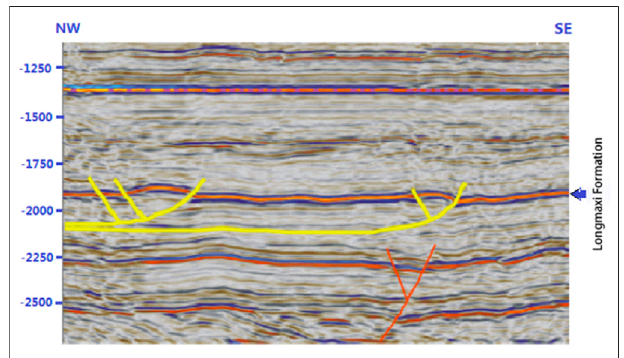
FIGURE 4 | Stratum and style of Indosinian tectonic